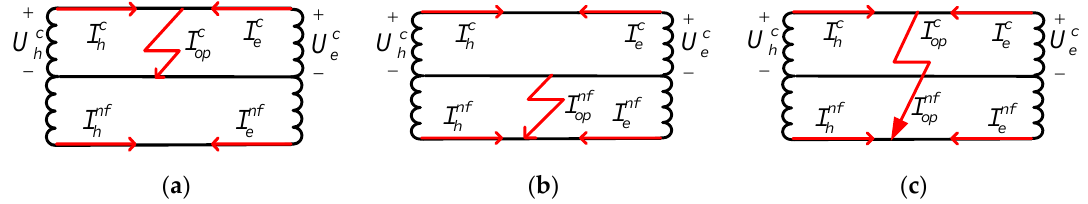
Figure 7. Current and voltage distribution at the AT subsection in the cases of fault with low transition resistance: ( a ) In C-G short circuit; ( b ) in NF-G short circuit; and ( c ) in C-NF short circuit.